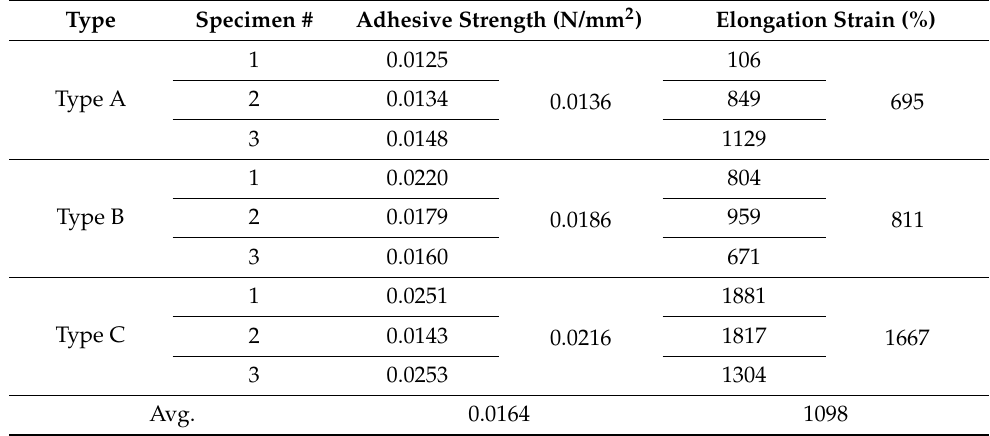
Table 4. Adhesion and Elongation measurement